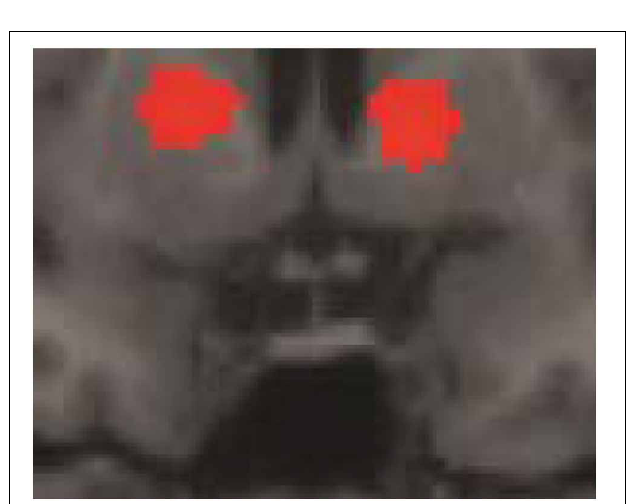
FIGURE 4 | Basal ganglia activations. Preference classification vs. sensorimotor decision baseline on day 5. The effect was present but smaller on day 1 (day 5 vs. day 1; cluster P FWE = 0 . 012; [x, y, z] = [ − 24, − 6, − 4], P FDR = 0 . 012, small-volume correction).